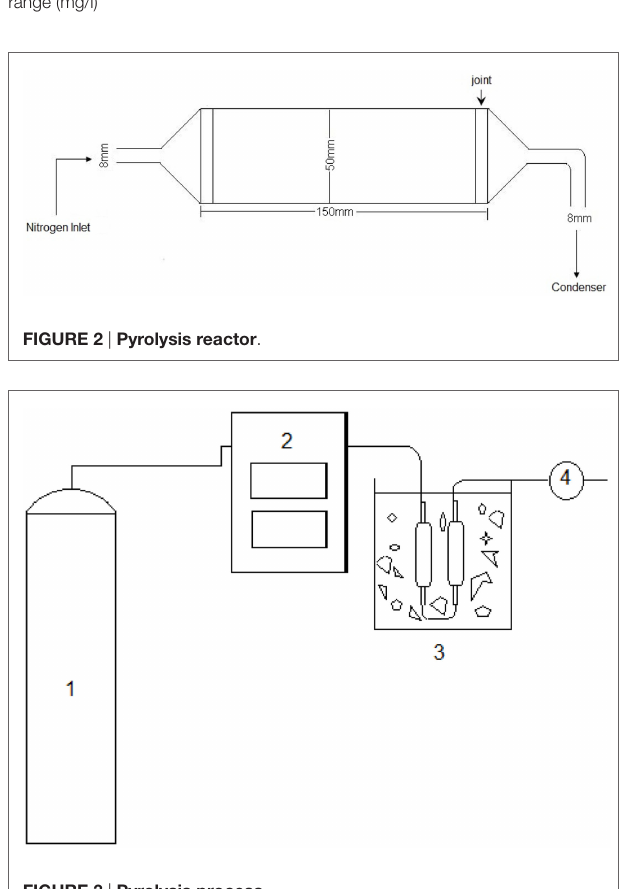
FigUre 3 | Pyrolysis process .